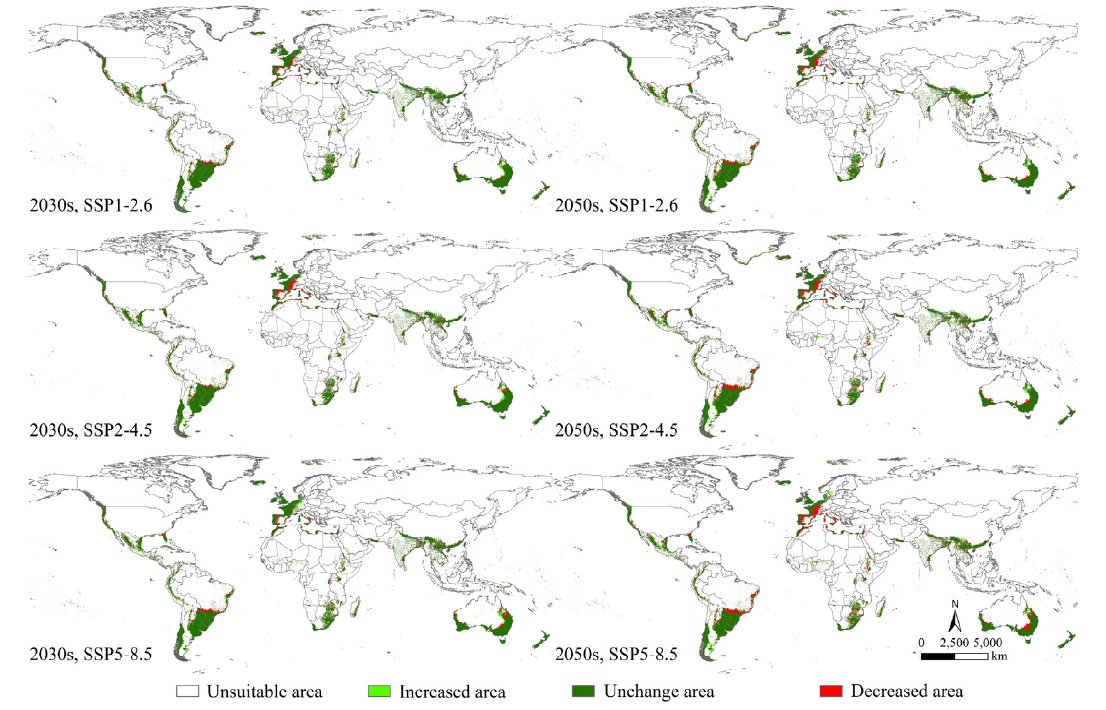
Figure 5. Changes in the potential geographical distribution of Phoracantha semipunctata between the near-current and future climates.